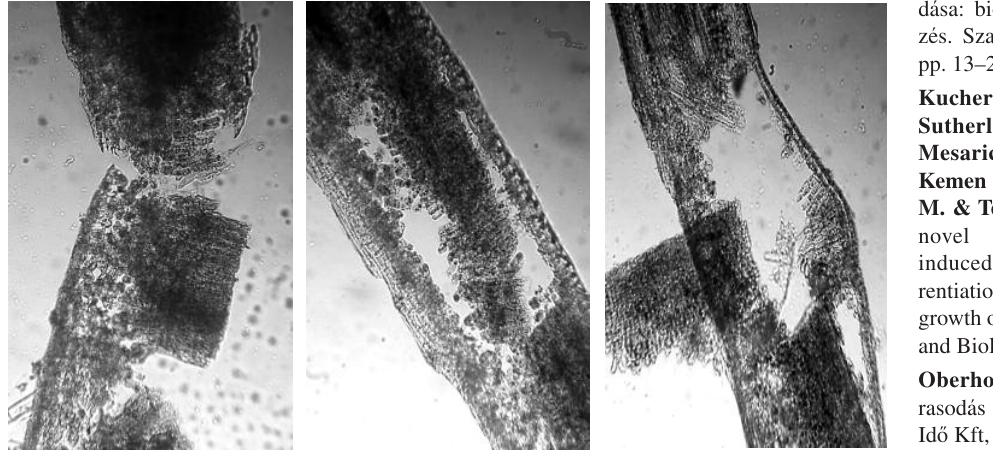
Figure 2. Tissue structure falling apart in cultivar ‘Watson Jonathan’. From entirely unbroken preparations leaf blade broke in many parts after 1–2